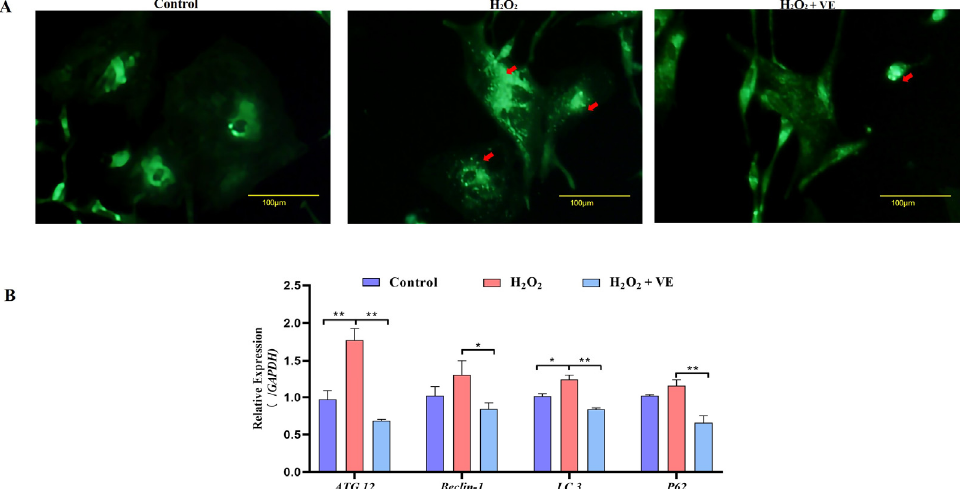
Figure 13. Changes in the levels of autophagy induced by VE antioxidants under H 2 O 2 -induced oxidative stress. ( A ) GCs transfected with an MDC plasmid and subjected to H 2 O 2 -induced oxidative stress were incubated with VE. Laser confocal-scanning microscopy was used to observe fluorescent GFP puncta in the GCs. Scale bar = 100 µ m. The cells were incubated with 0.05 mM MDC for 10 min at 38.5 °C and then washed 4 times with PBS (pH 7.4). The cells were immediately analyzed by fluorescence microscopy and quantified. Red arrow: Laser confocal scanning microscopy was used to observe the fluorescent autolysosomes puncta in GCs. ( B ) Expression of ATG12 , Beclin1 , LC3 and p62 after treatment with VE under H 2 O 2 -induced oxidative stress ( n = 3). All the data represent the means (± SE) of 3 independent experiments (* p < 0.05; ** p < 0.01).